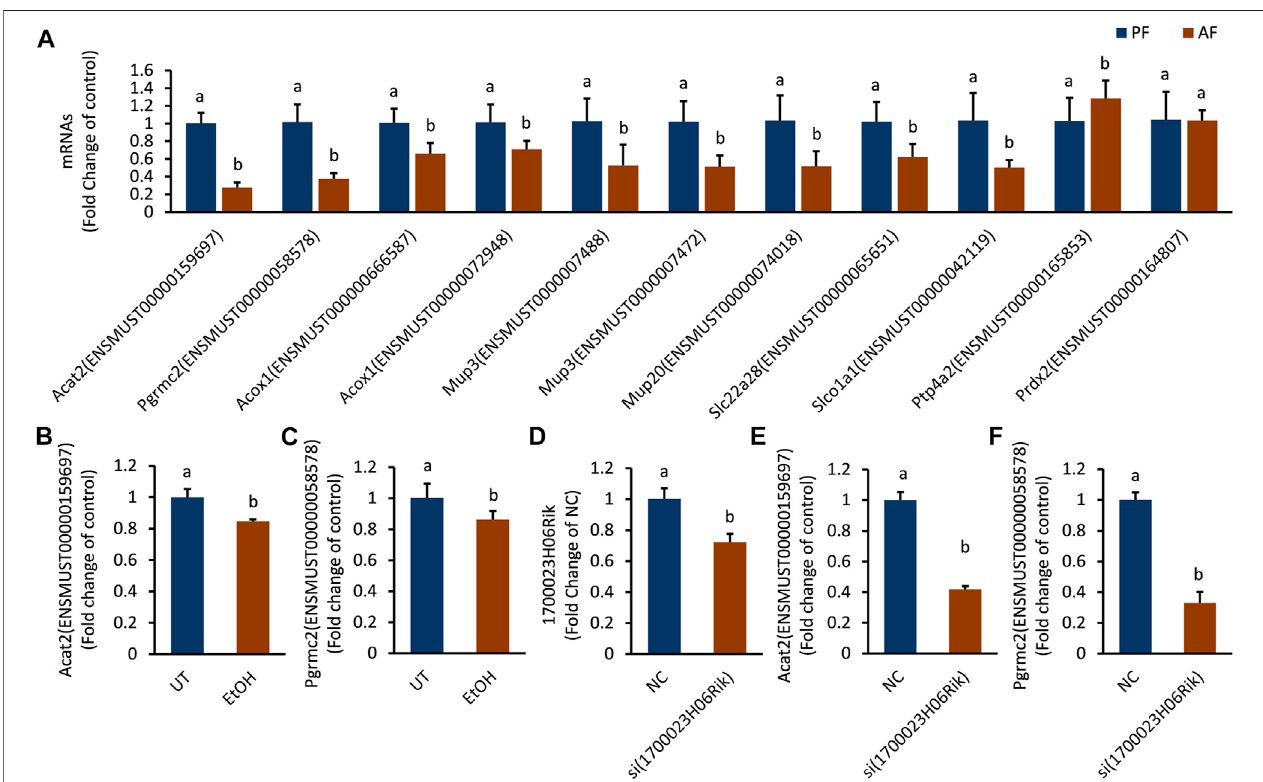
FIGURE 6 | The expression trend of mRNAs corresponding to lnc_1700023H06Rik. (A) The expression trends of 11 mRNAs in mouse liver tissues. (B,C) Expression of Acat2, Pgrmc2 in ethanol-treated AML-12 cells. (D) 1700023H06Rik expression in AML-12 cells by siRNA. (E,F) Expression of Acat2 and Pgrmc2 after knocking down lnc_1700023H06Rik.